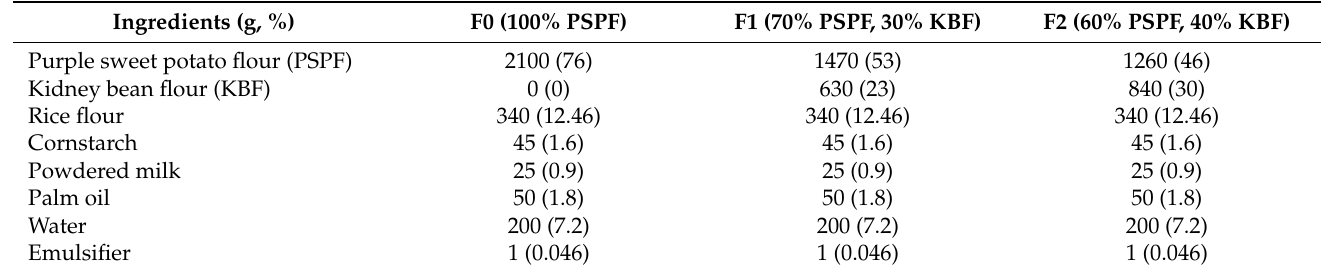
Table 1. Formulation of extruded purple sweet potatoes with three levels of kidney bean flour substitution (0, 30, and 40%).